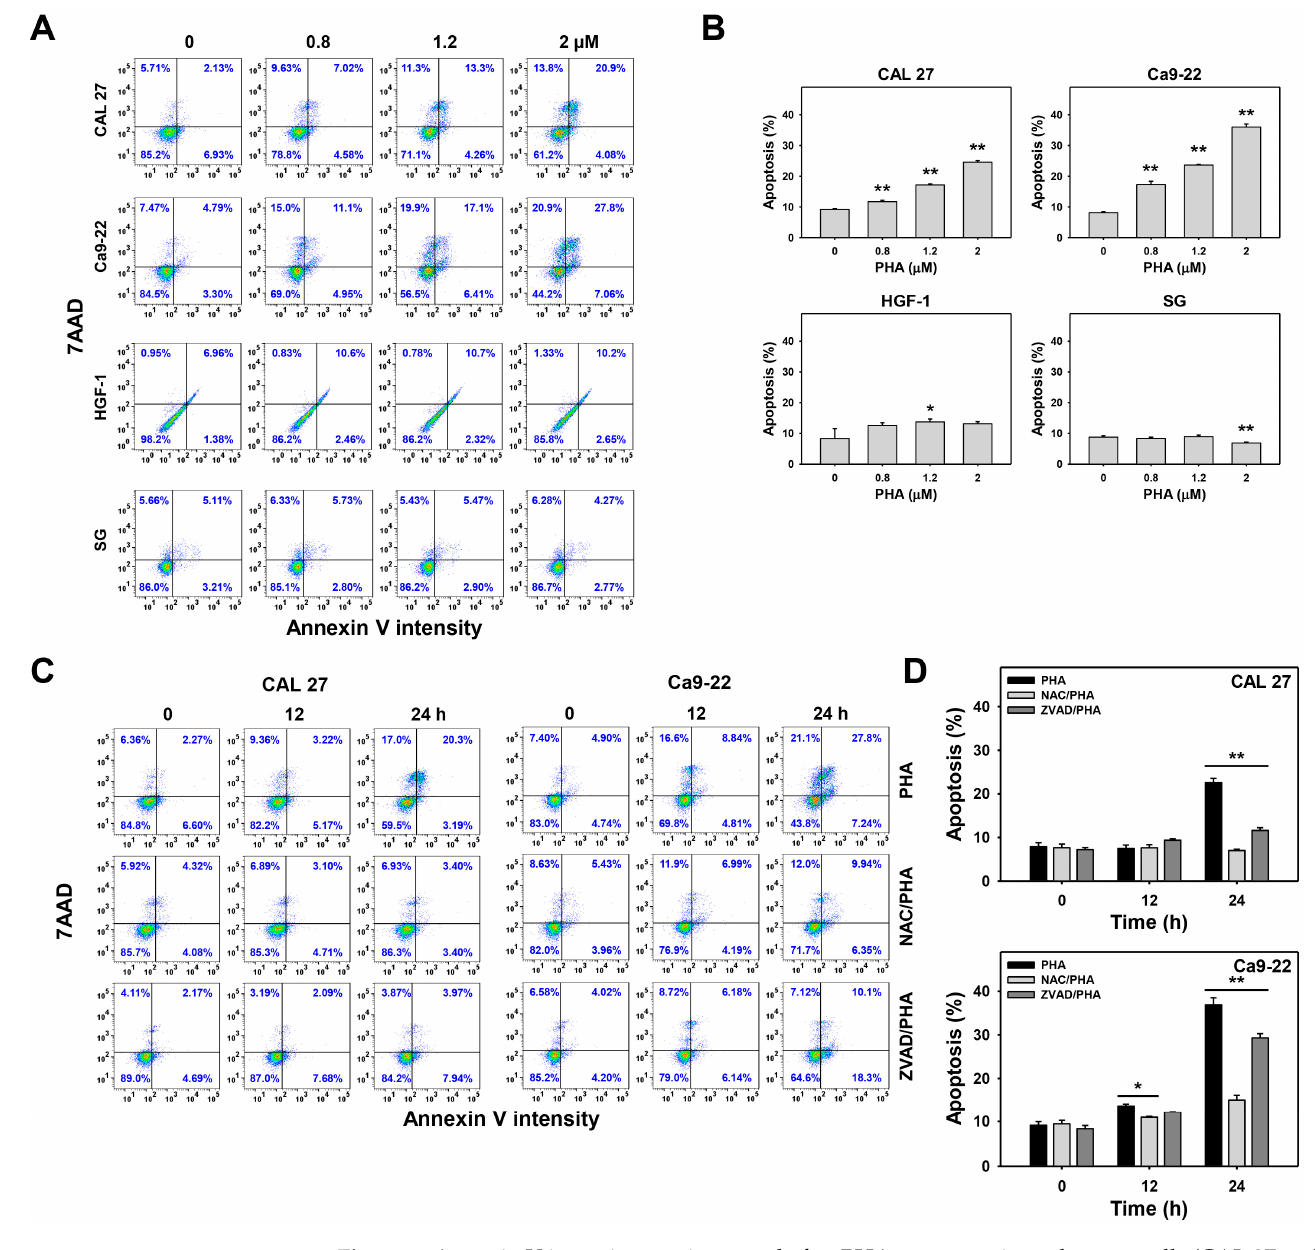
Figure 3. Annexin V intensity was increased after PHA treatment in oral cancer cells (CAL 27 and Ca9-22) but not for non-malignant oral cells (HGF-1 and SG). ( A , B ) Annexin V/7AAD analysis. Cells were exposed to 0 (0.1% DMSO medium as control), 0.8, 1.2, and 2 μ M PHA for 24 h. 7AAD (+/ − )/annexin V (+) (%) was counted for apoptosis (+) (%). ( C , D ) Suppression of PHA-induced apoptosis by NAC or ZVAD. To evaluate the recovery effect of NAC and ZVAD, NAC (10 mM for 1 h) or ZVAD (100 μ M for 2 h) were added to cells before 12 and 24 h treatment with PHA (control (0.1% DMSO medium) and 2 μ M), i.e., NAC/PHA or ZVAD/PHA. Data, means ± SDs ( n = 3 independent experiments); * and ** indicate p < 0.05 and 0.001.